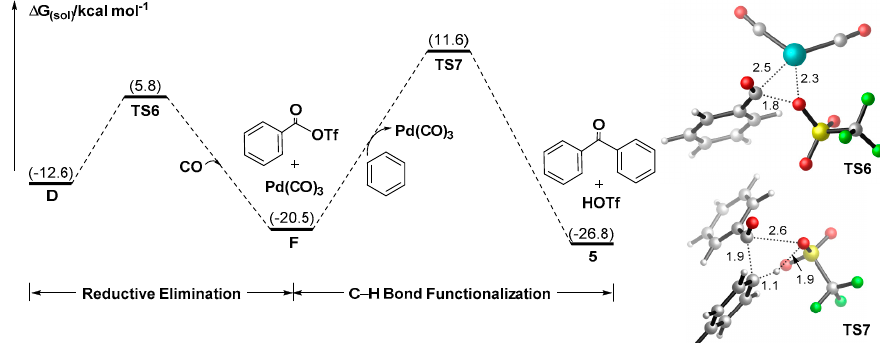
Figure 4. Reaction potential surfaces for the formation of ketones delivered by resultant aroyl triflate.